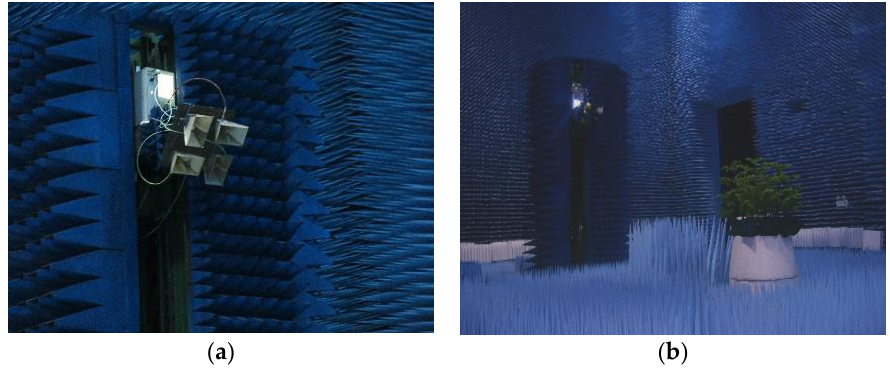
Figure 12. The measurement system of PolSAR. Sensors 2017 , 17 , 295